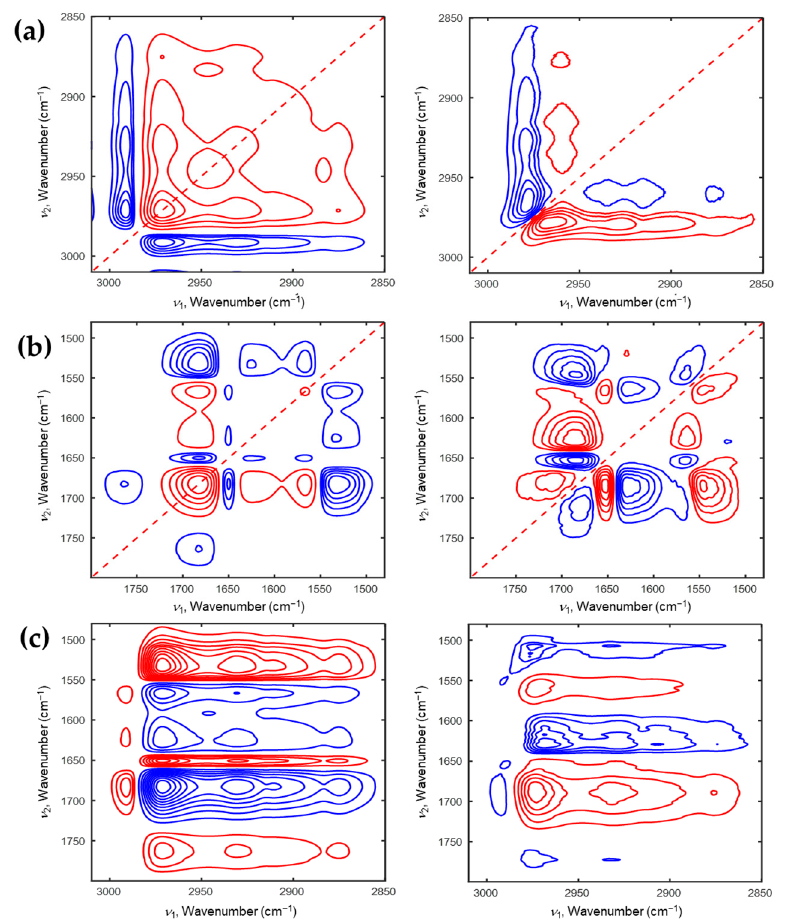
Figure 6. 2D correlation spectra of P(NiPAAm- co -AAc) hydrogel of pH2 during the cooling process ( a : 3010–2850 cm − 1 , b : 1800–1480 cm − 1 ). Hetero-mode 2D correlation spectra ( c ) of P(NiPAAm- co -AAc) hydrogel during the cooling process for the 3010–2850 cm − 1 and 1800–1490 cm − 1 regions.